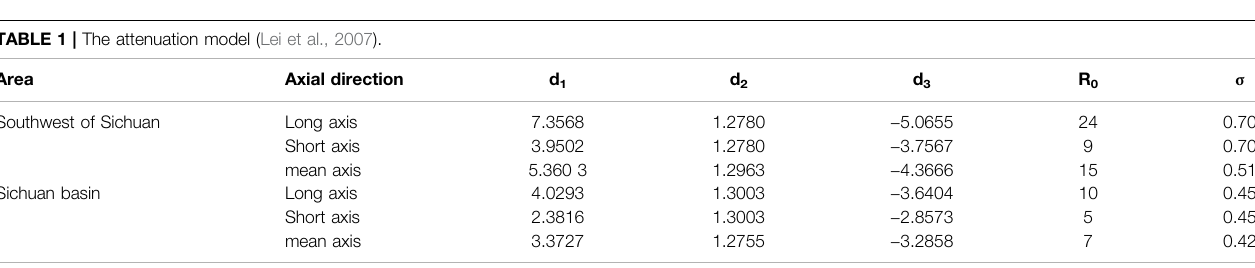
TABLE 1 | The attenuation model (Lei et al., 2007).